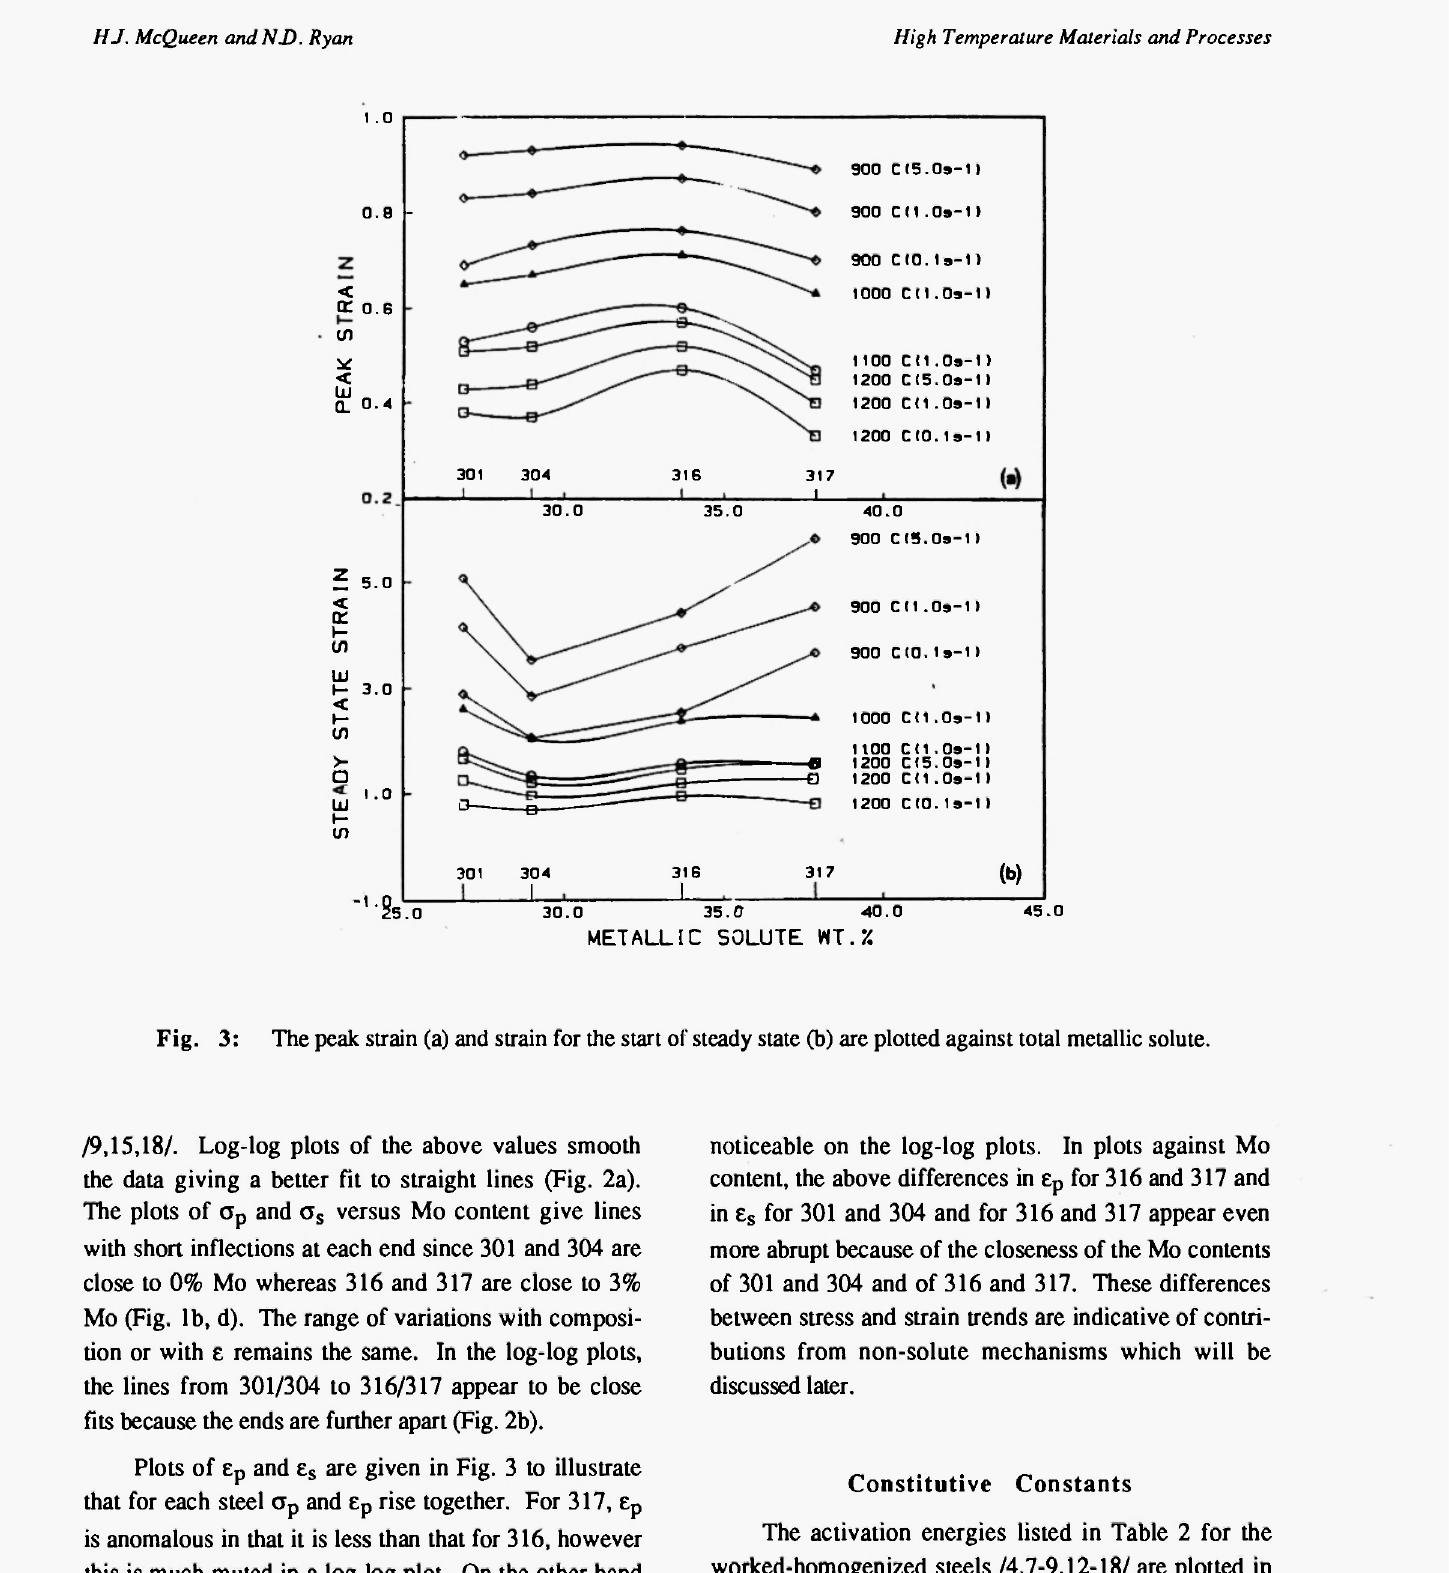
/9,15,18/. Log-log plots of the above values smooth the data giving a better fit to straight lines (Fig. 2a). The plots of σ ρ and σ 5 versus Mo content give lines with short inflections at each end since 301 and 304 are close to 0% Mo whereas 316 and 317 are close to 3% Mo (Fig. lb, d). The range of variations with composi- tion or with ε remains the same. In the log-log plots, the lines from 301/304 to 316/317 appear to be close fits because the ends are further apart (Fig. 2b). Plots of ε ρ and e s are given in Fig. 3 to illustrate that for each steel σ ρ and ε ρ rise together. For 317, ε ρ is anomalous in that it is less than that for 316, however this is much muted in a log-log plot. On the other hand the steady state strain is markedly higher for 301 than for 304 and for 317 than for 316; these changes are still